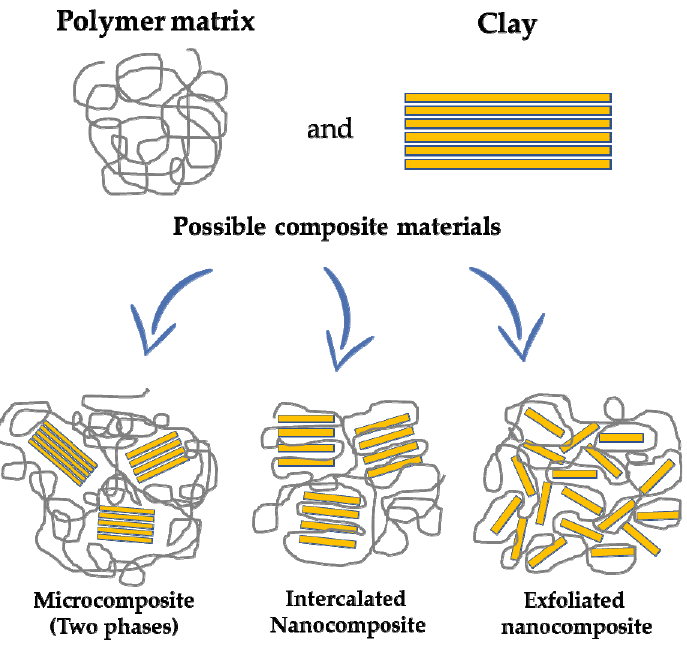
Figure 7. Different types of clay-based composite materials.